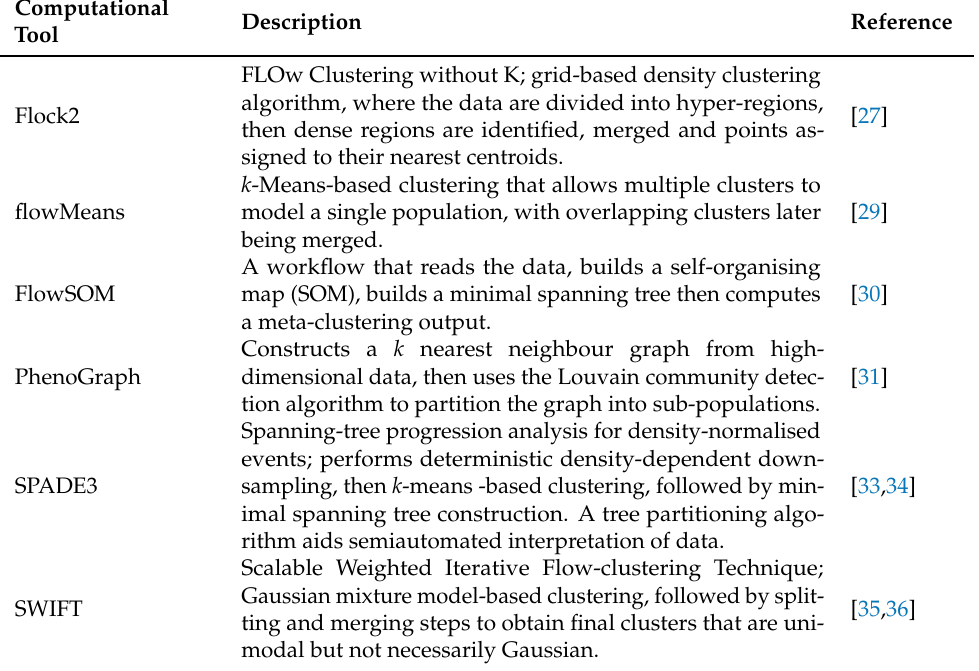
Table 1. Description of computational tools used in this